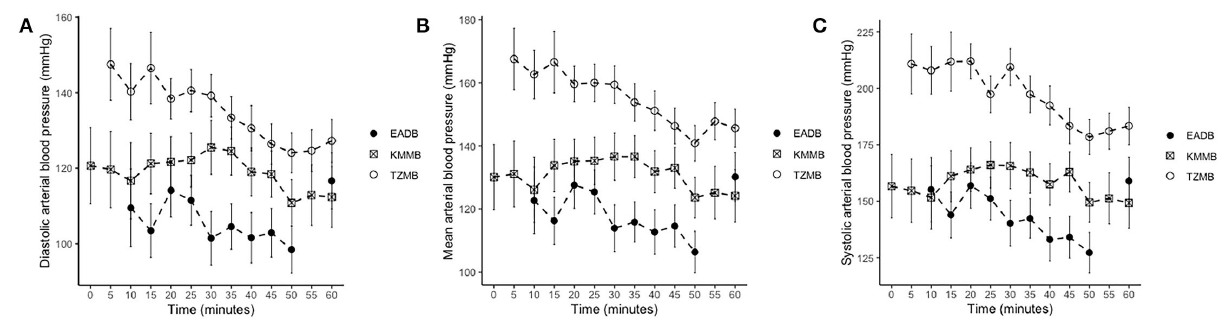
hypoxemic over the course of immobilization ( Figure 4 , Table 7 ) (26). In addition, PaCO 2 levels indicated normocapnia for the ( Figure 3